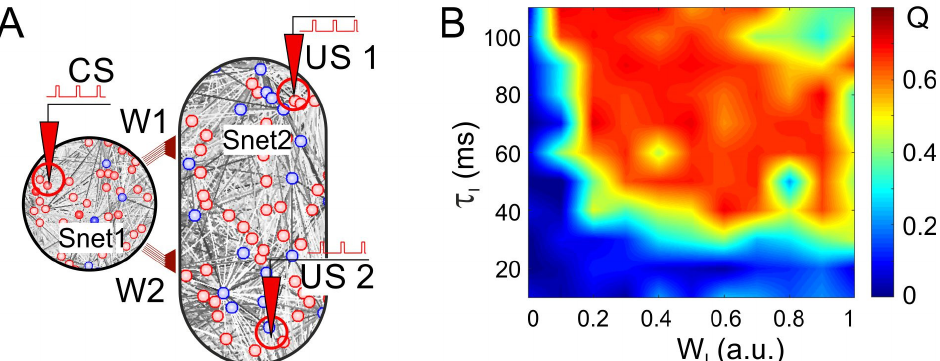
Figure 6. Neural competition enables associative learning of conditional stimulus with two unconditional ones. ( A ) Modular SNN with a single conditional stimulus CS and two unconditional stimuli (US1, US2) applied to a single elongated module. Inhibitory interneurons, which suppress the spread of excitation in subnet 2, provide neuronal competition and association of CS either with US1 or US2. ( B ) Learning quality Q as a function of the parameters of inhibitory connections: coupling weight W I and decay time τ I .